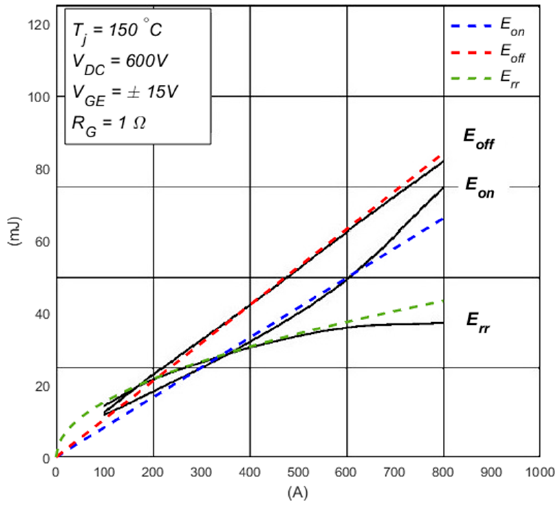
Figure 2. Switching energy losses graphs, comparison between the method SW1 and datasheet.